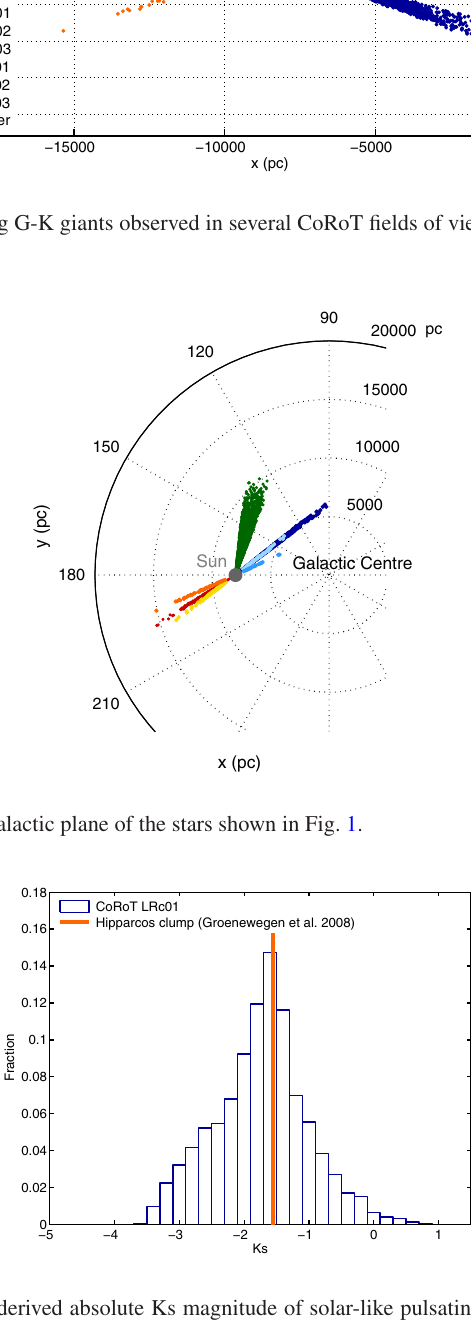
Figure 3. Distribution of the derived absolute Ks magnitude of solar-like pulsating giants in CoRoT LRc01. The vertical line shows the absolute magnitude of the Hipparcos red clump